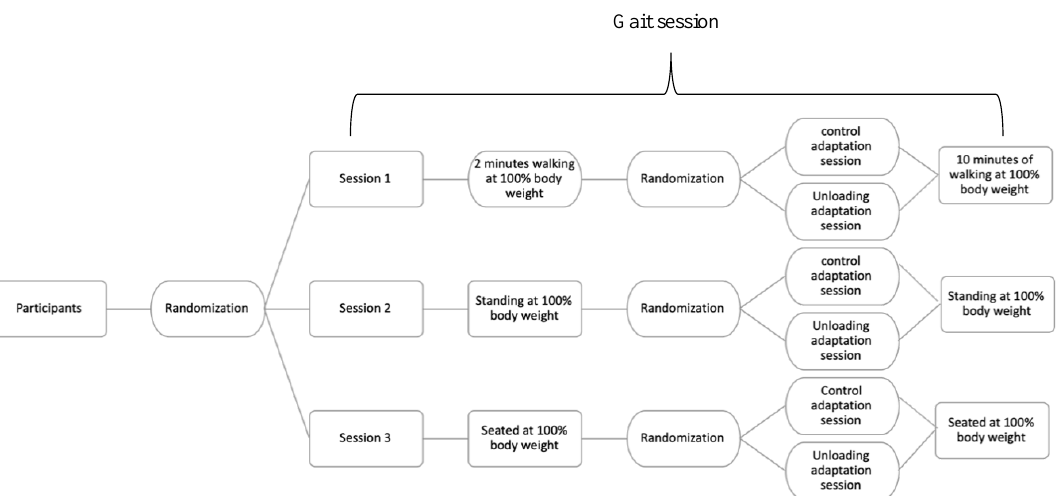
Figure 1. Flow chart describing the experimental design of the study.